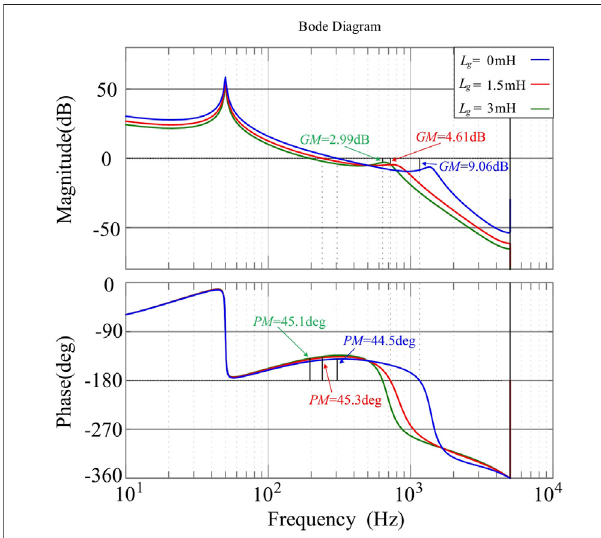
FIGURE 6 | Bode plot for G op ( z ).